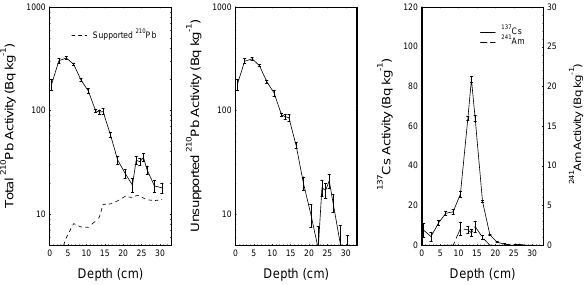
Figure 1. Profiles of 210 Pb, 137 Cs, and 241 Am, concentrations versus depth in a young fen from James Bay,